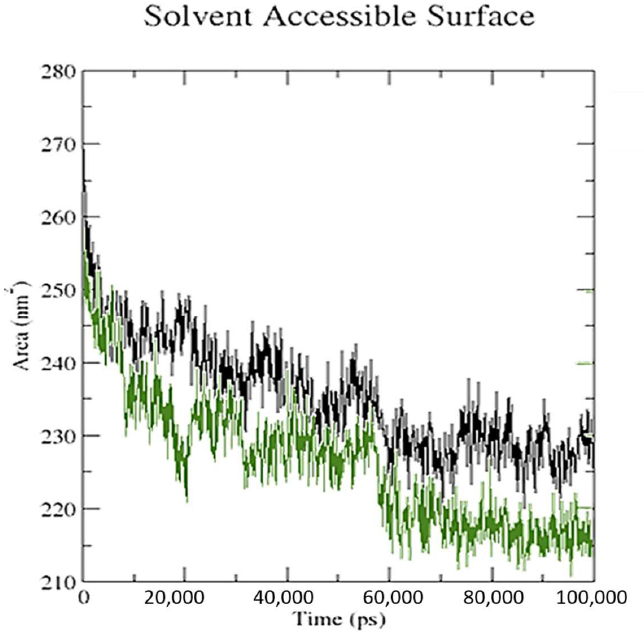
Figure 16. Solvent accessible surface area analysis for the SRXD complex (black) and the CTcD complex (green) during 100 ns simulation time.